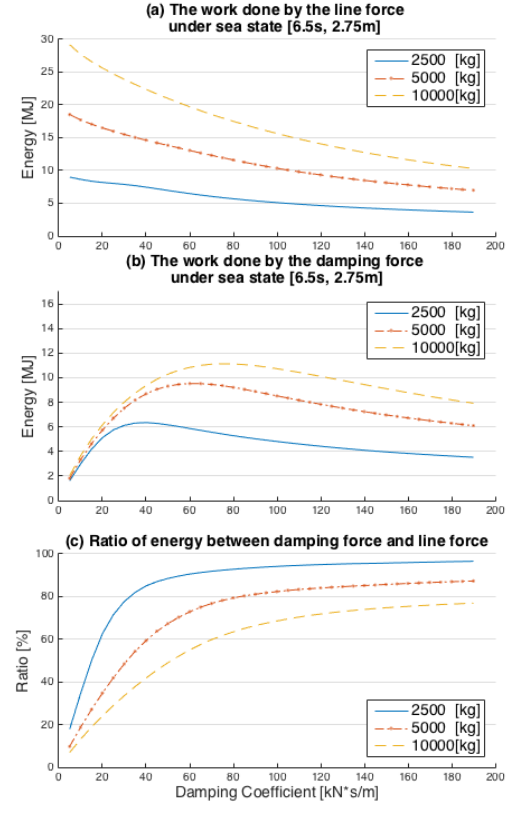
Figure 7. The converted energy of the WEC under sea state (6.5 s, 2.75 m), with a variation of damping coefficients from 5 kNs/m to 190 kNs/m: ( a ) energy dissipated in the absorbing process through the line; ( b ) energy absorbed by the generator for conversion; ( c ) the ratio of energy converted from the buoy to the generator.